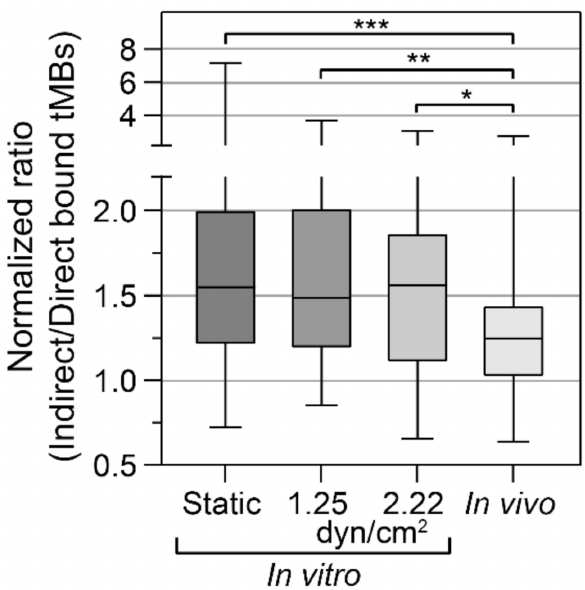
Figure 3. Binding efficacy of direct versus indirect targeted microbubbles (tMBs), plotted as the ratio of indirect:direct bound microbubbles per condition, normalized to the median ratio (indirect:direct microbubbles) of the control without cells. Static ( N = 186 FOVs), shear stress 1.25 dyn/cm 2 ( N = 47 FOVs), shear stress 2.22 dyn/cm 2 ( N = 23 FOVs), and in vivo in the CAM model ( N = 66 FOVs). Boxplots show the median, IQR and whiskers from minimum to maximum. Statistical significance is indicated with * p < 0.05, ** p < 0.01, *** p < 0.001. Only results from FOVs with >5 bound direct and >5 bound indirect microbubbles are